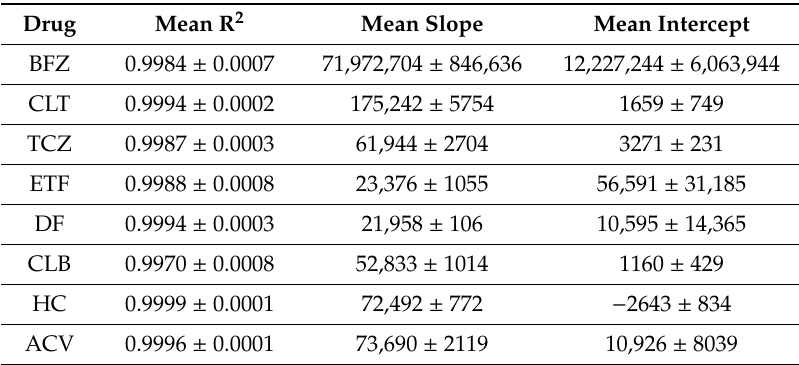
Table 7. Results obtained from the regression analysis using the least squares method for all studied drugs. Results are expressed as mean ± standard deviation (SD), n = 4. Please note that a weighted linear regression was performed on calibration data using 1 / x 2 as the weighting factor.